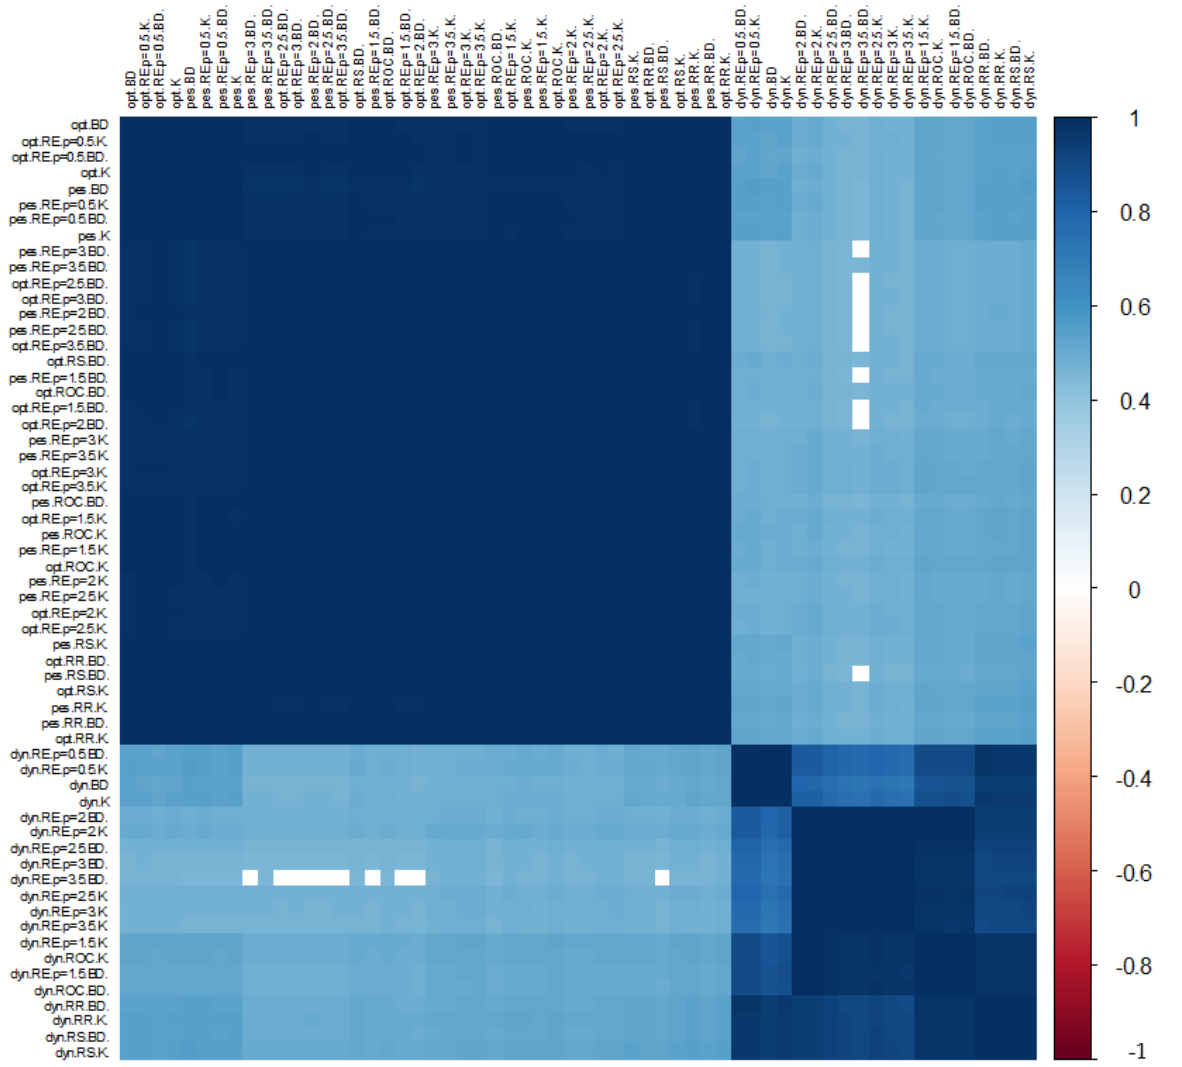
Figure 9. Illustration of the value of Pearson correlation coefficients for KPIs by the approaches used in the construction of indicators. Source: authors’ own material based on the GUS data.